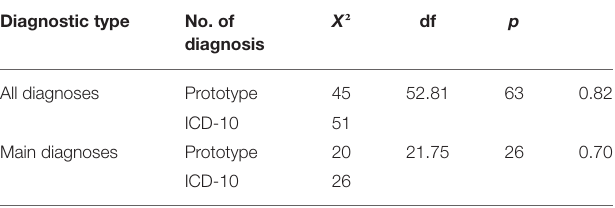
TABLE 2 | Number of prototype vs. ICD-10 operational-based diagnosis. Diagnostic